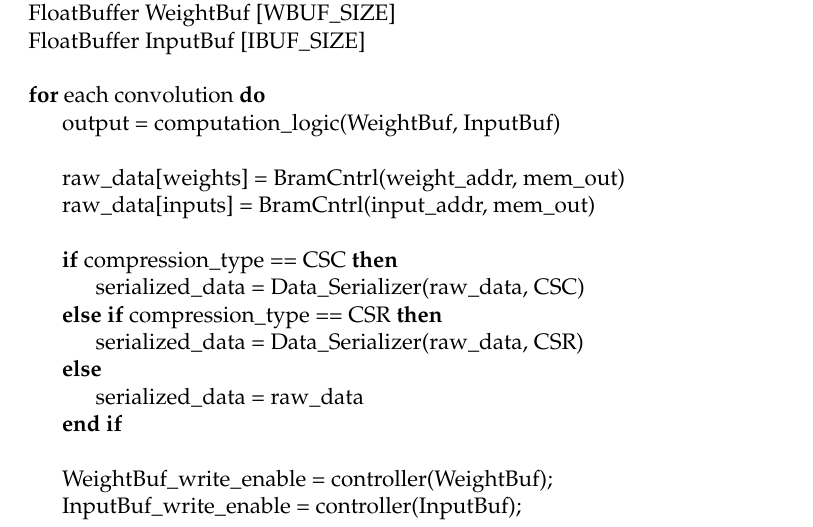
Algorithm 1 HLS pseudocode of the